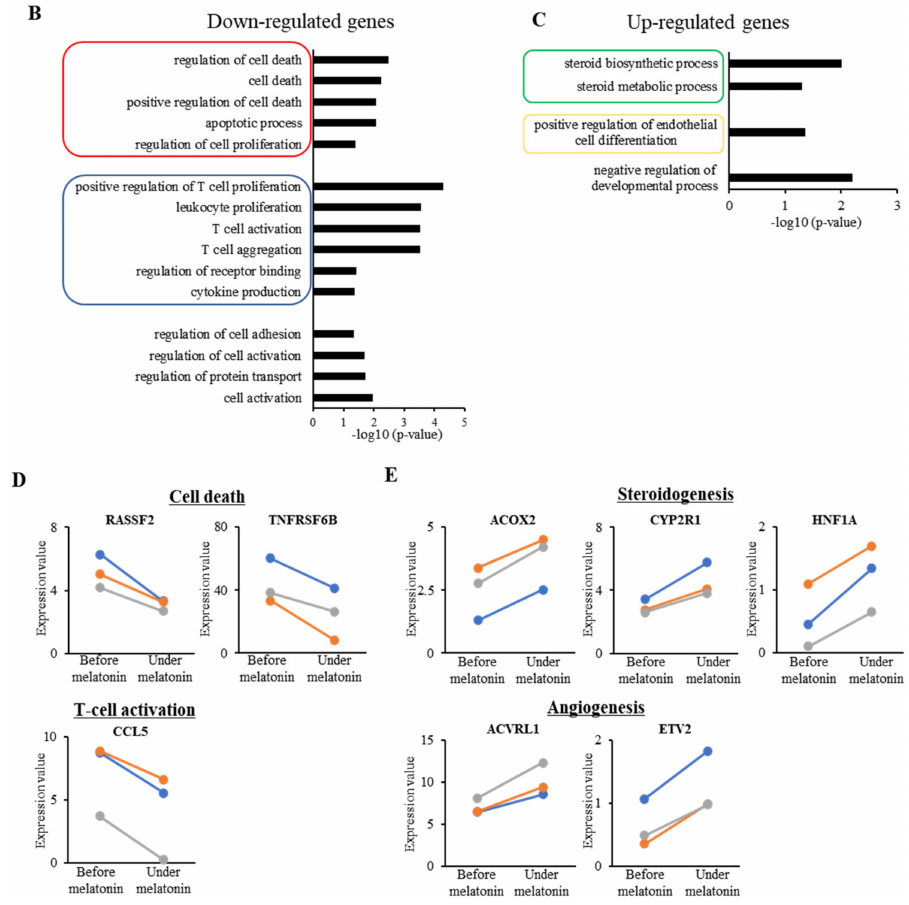
Figure 3. Effect of melatonin treatment on transcriptome profile in GCs. ( A ) Hierarchical cluster analysis comparing the transcriptome in GCs. Each color indicates the cases before melatonin treatment (Cases No. 1-3, blue), under melatonin treatment (Cases No. 1-3, green) and the cases with good ART outcomes without melatonin treatment (Cases No. 4-7, yellow). Distances of gene expression pattern are indicated as height. ( B ) Enriched gene ontology terms and p -values in down- regulated genes by melatonin treatment. The terms circled in red are associated with cell death, and the terms circled in blue are associated with T-cell activation. ( C ) Enriched gene ontology terms and p -values in up-regulated genes by melatonin treatment. The terms circled in green are associated with steroidogenesis, and the terms circled in yellow are associated with angiogenesis. ( D ) Changes in mRNA expression level of the representative down-regulated genes by melatonin treatment. Expression values before and under melatonin treatment are shown as dot plots of TPM determined by RNA-sequence. Blue line and dots; Case 1. Orange line and dots; Case 2. Gray line and dots; Case 3. Gene names and associated cellular functions are shown above the graphs. ( E ) Changes in mRNA expression level of the representative up-regulated genes by melatonin treatment. Expression values before and under melatonin treatment are shown as dot plots of TPM determined by RNA-sequence. Blue line and dots; Case 1. Orange line and dots; Case 2. Gray line and dots; Case 3. Gene symbols and associated cellular functions are shown above the